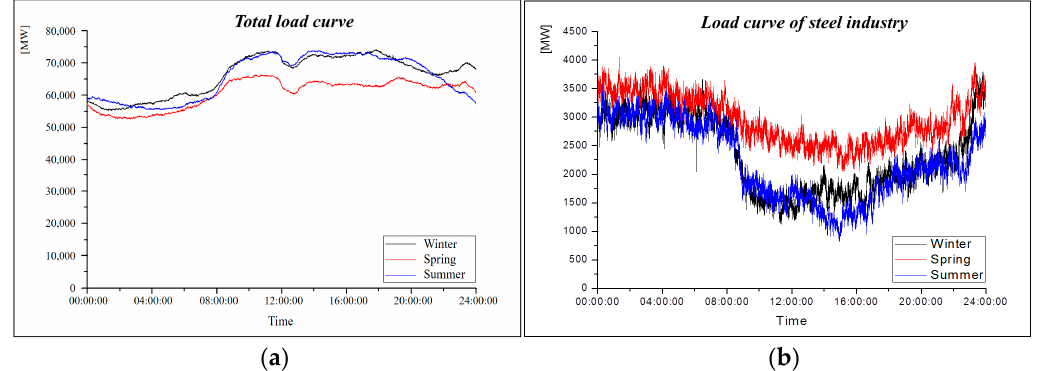
Figure 1. The daily load curves in South Korea: ( a ) Load curves of total power system; ( b ) Daily load